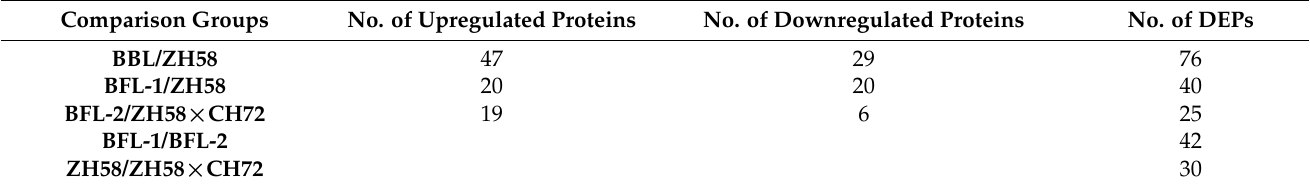
Table 2. Summary of the number and regulated state of the DEPs in the different comparison